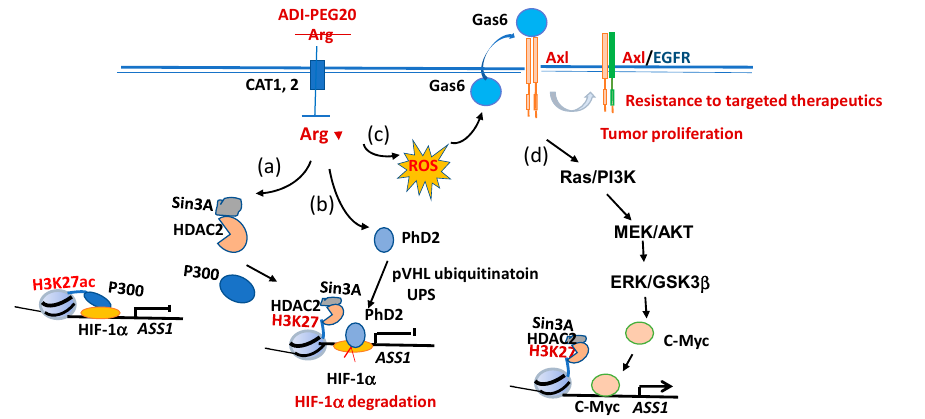
Figure 2. Mechanisms of argininosuccinate synthetase (ASS1) induction by Arg starvation. Arg- depleting recombinant proteins such as pegylated arginine deiminase (ADI-PEG20) digests extracel- lular Arg, resulting in the depletion of intracellular Arg. ( a ) Before ADI-PEG20 treatment, ASS1 is silenced by HIF-1 α binding to its promoter due to the association of histone acetyltransferase p300, which acetylates H3K14ac and H3K27ac (for simplicity, only H3K27ac is indicated). ADI-PEG20 treatment prompts P300 dissociation from the promoter, allowing histone deacetylase HDAC2 and co-factor Sin3A to deaceacetylate histone H3K27ac and H3K14ac. ( b ) Propyl hydroxylase (PhD2)– pVHL ubiquitine–proteosomal system moves in to the ASS1 promoter and destroys HIF-1 α (see reference 54). ( c ) In the meantime, Arg deprivation generates reactive oxygen species (ROS), which triggers gas6 externalization to interact with the Axl receptor. ( d ) Axl activates the signal transduction involving Ras/PI3K, MEK/AKT and ERK/GSK3b resulting in the stabilization of c-Myc, which is a positive transcription factor to turn one ASS1 expression [55]. Then, elevated ASS1 feedbacks to suppress c-Myc and Axl